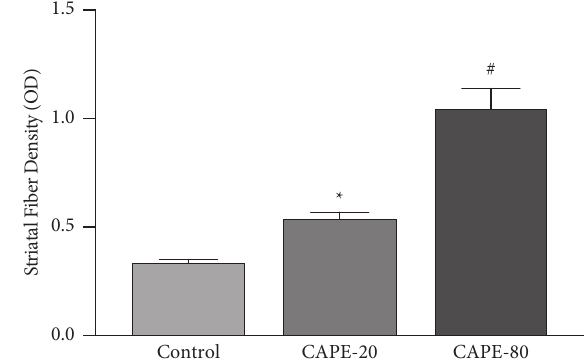
Figure 7: TH-immunostained striatal fiber density (OD) quanti- fied using ImageJ. Control group, n � 7; CAPE 20 group, n � 9; CAPE 80 group, n � 8. ∗ p < 0 . 05 CAPE-20 vs. control; and # p < 0 . 01 vs. CAPE-80 vs control.